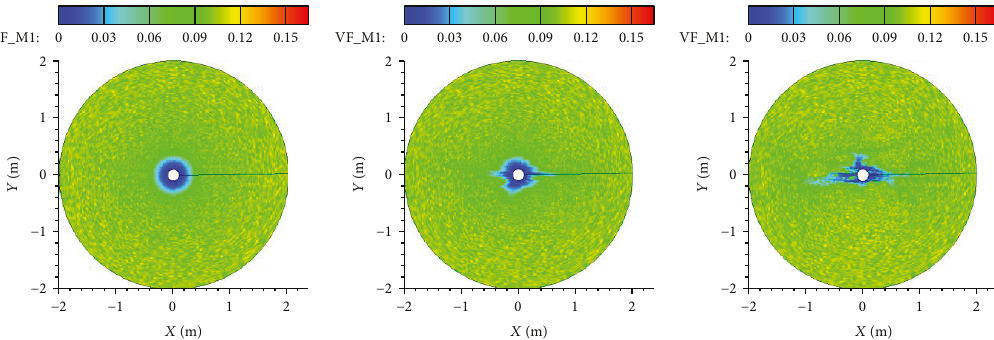
Figure 20: Fast-reacting mineral distribution after acidizing in two layers.